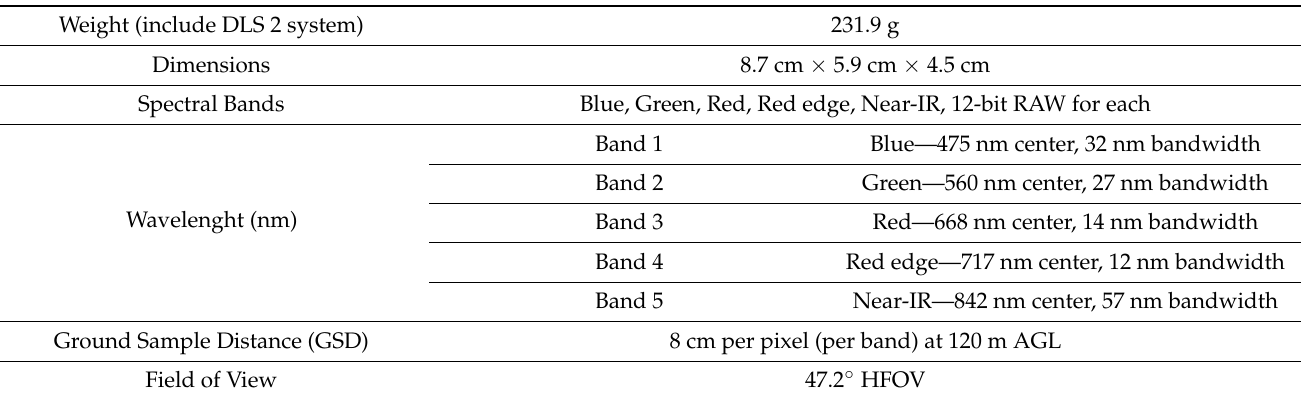
Table A2. Characteristics of the Micasense Red-Edge MX multispectral camera